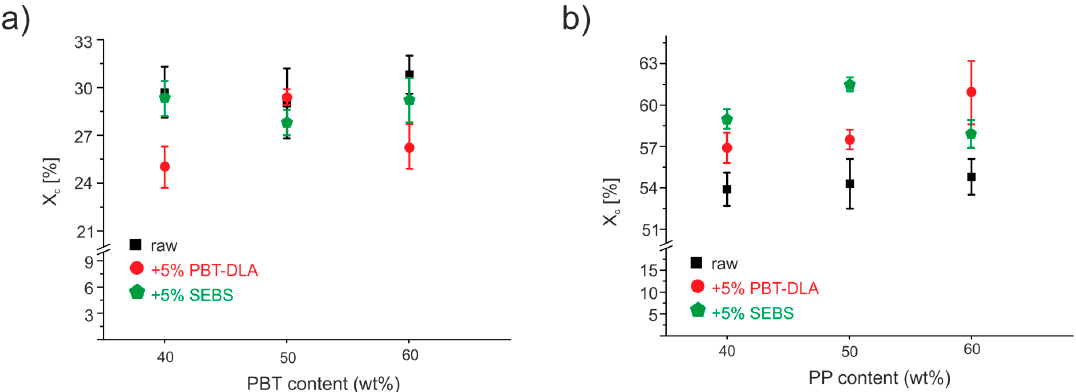
Figure 12. The effect of compatibilizer addition on degree of crystallinity of PP/PBT blends: ( a ) PBT phase; ( b ) PP phase. The data are presented as a mean of 3 measurements with standard deviations indicated by bars.